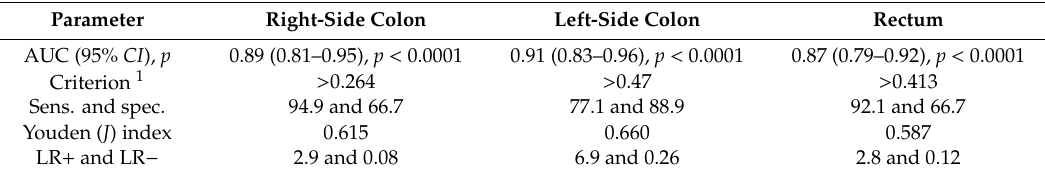
Table 7. Characteristics of SDMA / citrulline / DMA panel as a CRC biomarker with reference to the